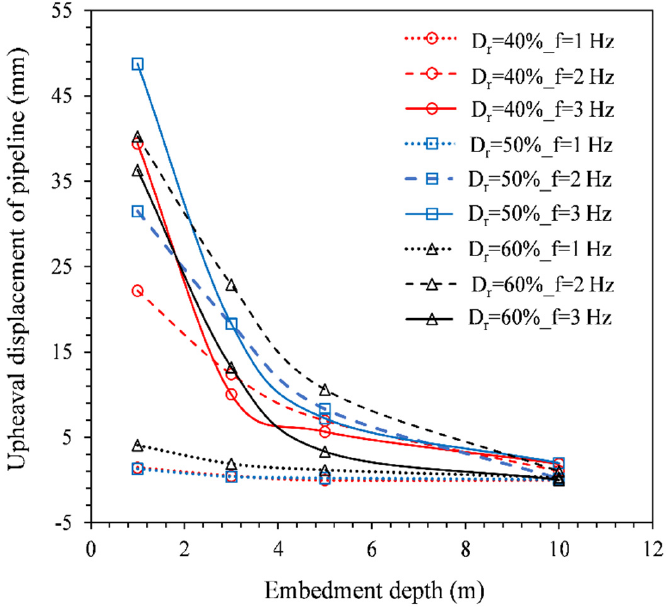
Figure 9. Variation of the upheaval displacement of the pipeline with the embedment depth of the pipeline.